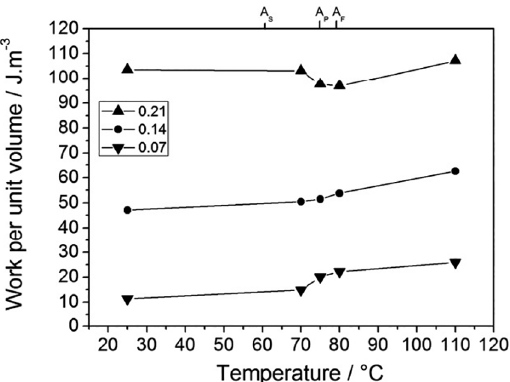
Figure 4. The uniform work calculated from the tensile testing of solution treated 2.080 mm diameter wire as a function of temperature for 0.07, 0.14, and 0.21 mm 2 .mm -2 area reduction.